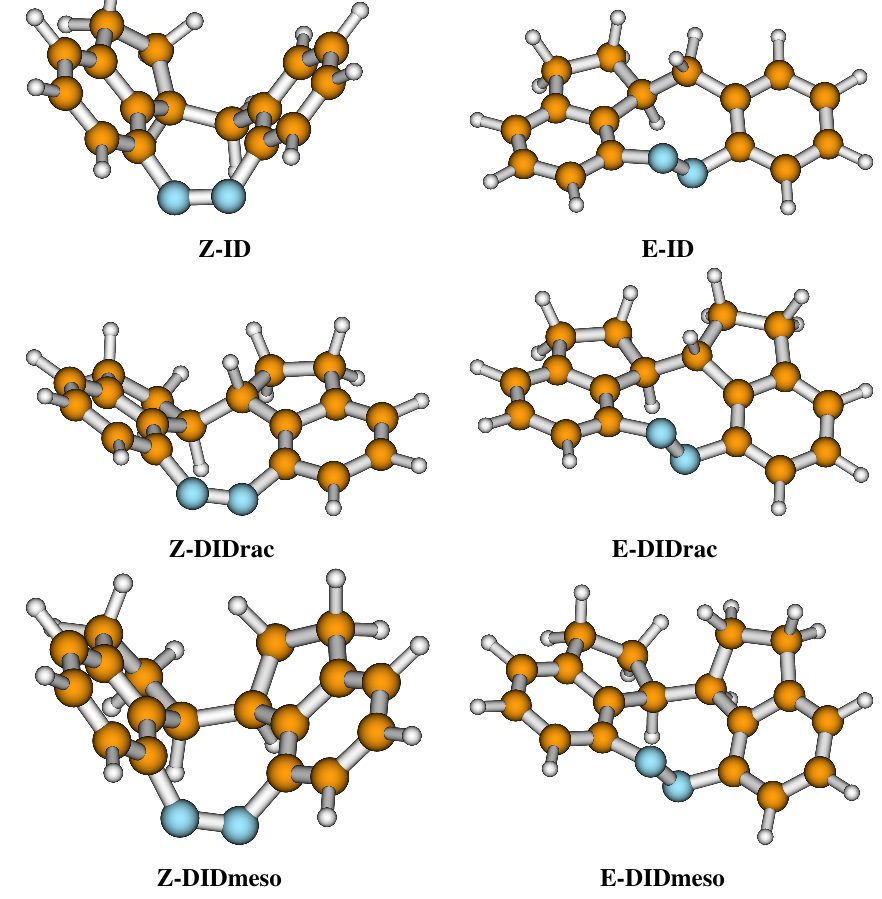
Figure 2. Optimized FOCI-AM1 ground-state